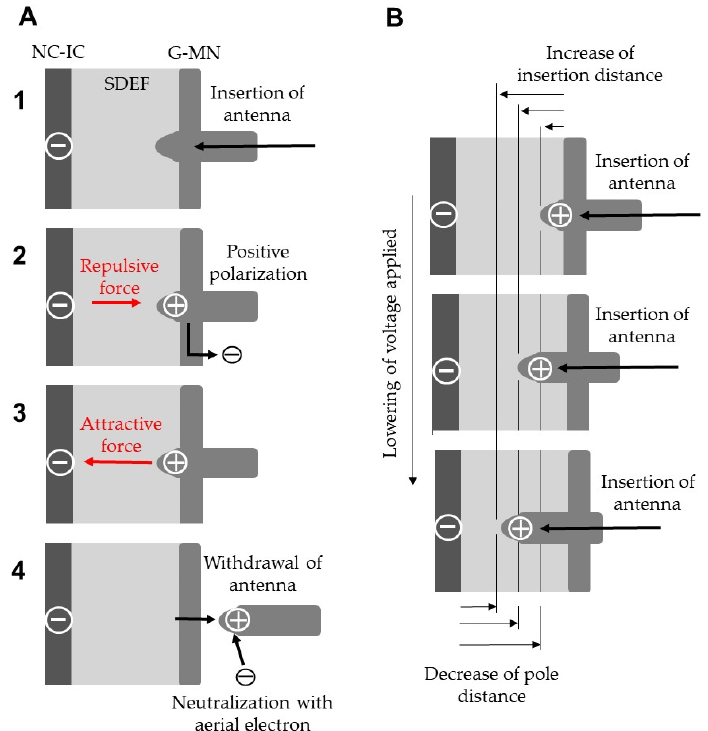
Figure 9. ( A ) Schematic representation of the electrostatic and biological events causing an insect to avoid entering an SDEF. ( B ) Relationship between applied voltage, antennae insertion distance within the SDEF, and pole distance (interval between the NC-IC and the tip of the antenna touching the G-MN) [29].